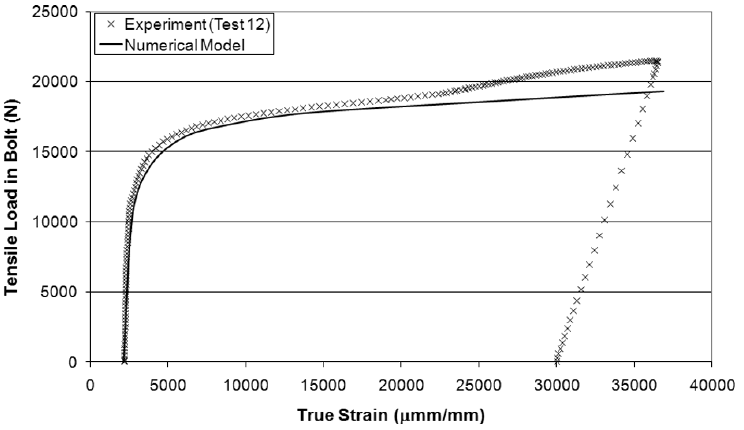
Fig. 10. Comparison with experimental load-strain data, static tension